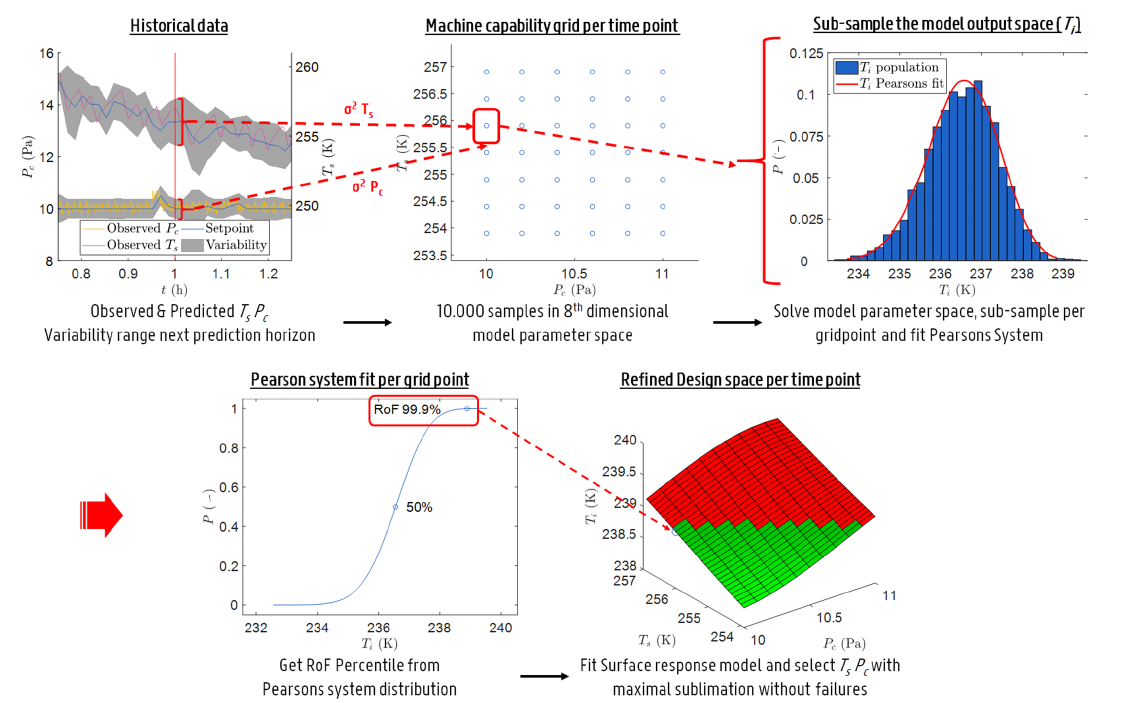
Figure 1. Schematic representation of the methodology used for the uncertainty